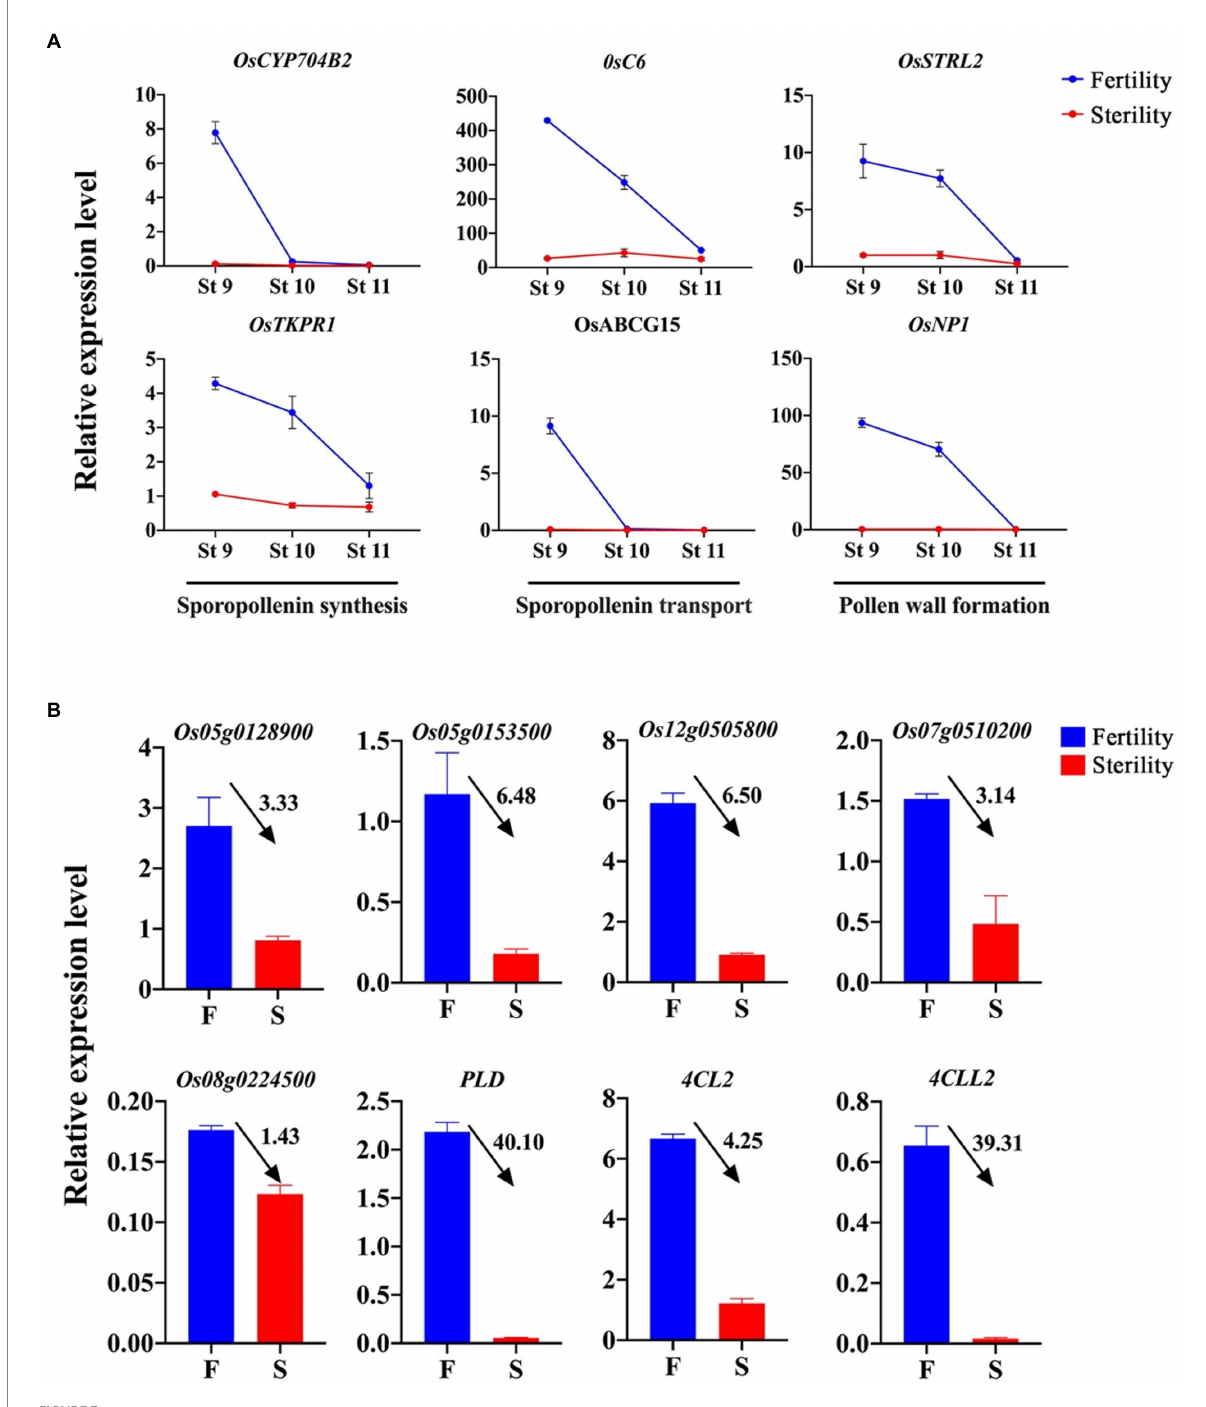
FIGURE 7 Expression of genes involved in pollen fertility formation and potential male fertility regulation. (A) Expression of genes for sporopollenin synthesis, sporopollenin transport and pollen wall formation. (B) Expression of inferred related genes involved in the regulation of male fertility. In B , numbers indicate the fold change of expression in fertility differential